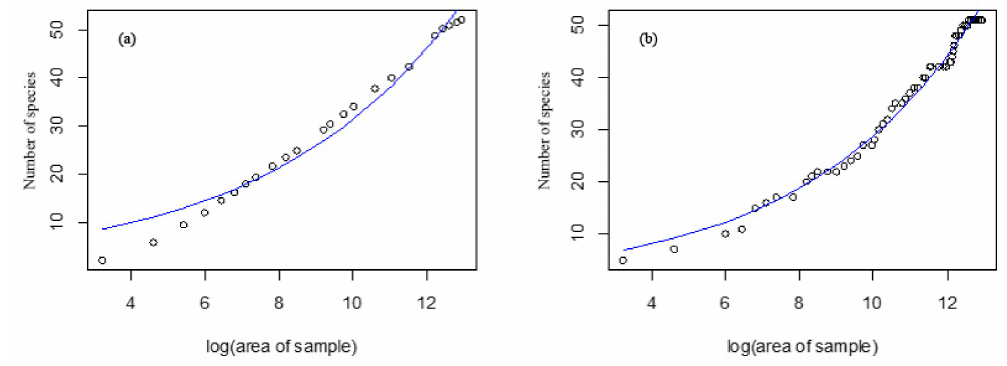
Figure 3. Log-log species-area curve of the logistic model of Jiaohe ( a ) and Mt. Changbai ( b